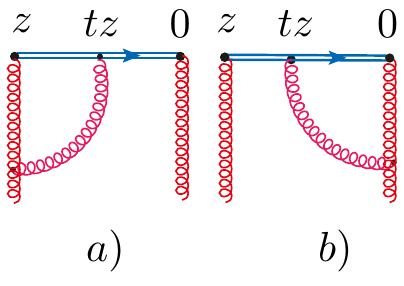
Figure 2 . Vertex diagrams with gluons coming out of the gauge